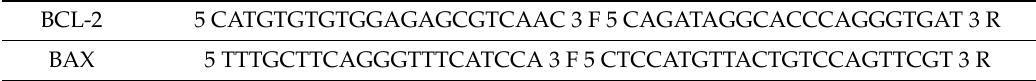
Table 3. Sequence